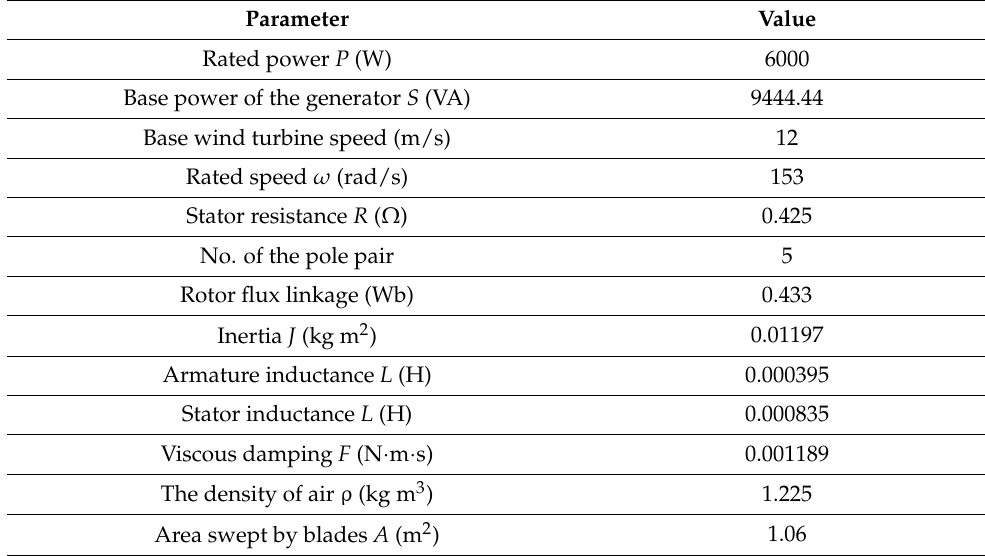
Table 1. Parameters of the PMSG wind turbine system